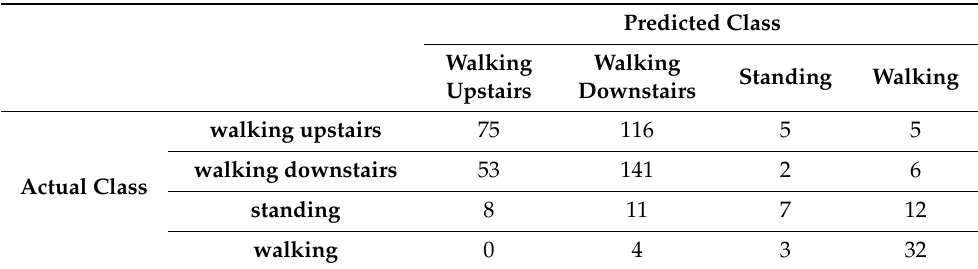
Table 1. Confusion matrix for normalized accelerometer data with MaxAbsScaler.